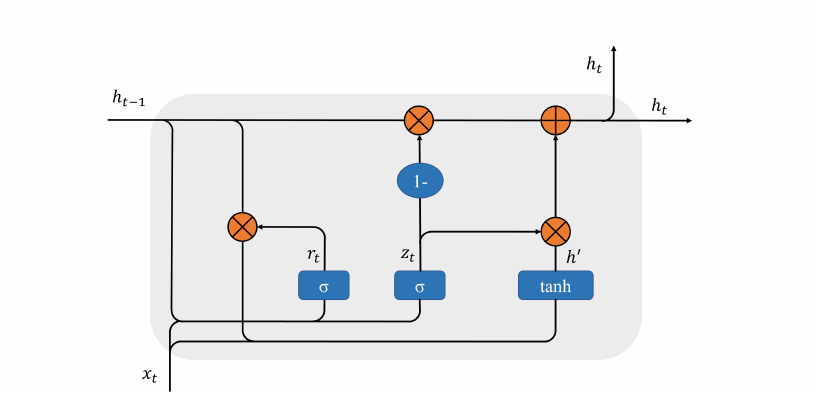
Figure 1. The structure of the GRU model. In the figure, x t is the current input, h t − 1 is the hidden state of the previous time node, and h t is the hidden state of the current node. σ is the sigmoid function. r t is the reset gate signal, and z t is the update gate signal.